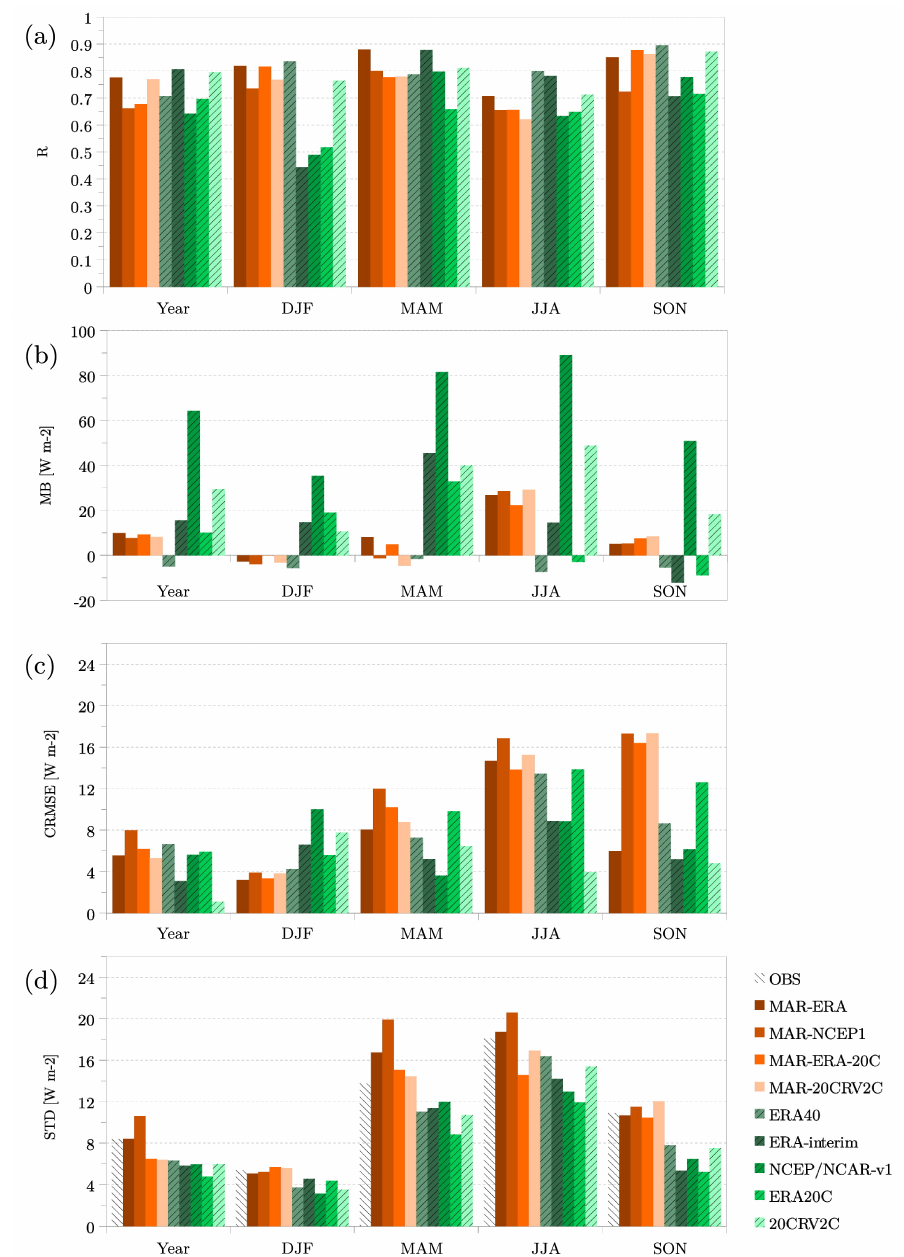
Figure 4. Modelled E g ↓ vs. observed E g ↓ at Saint-Hubert for 1962–2010: ( a ) annual and seasonal correlation (R); ( b ) mean annual bias (MB); ( c ) centred root mean squared error (CMRSE); and ( d ) standard deviation (STD). It should be noted that ERA40 covers 1962–1978, while the ERA-Interim covers